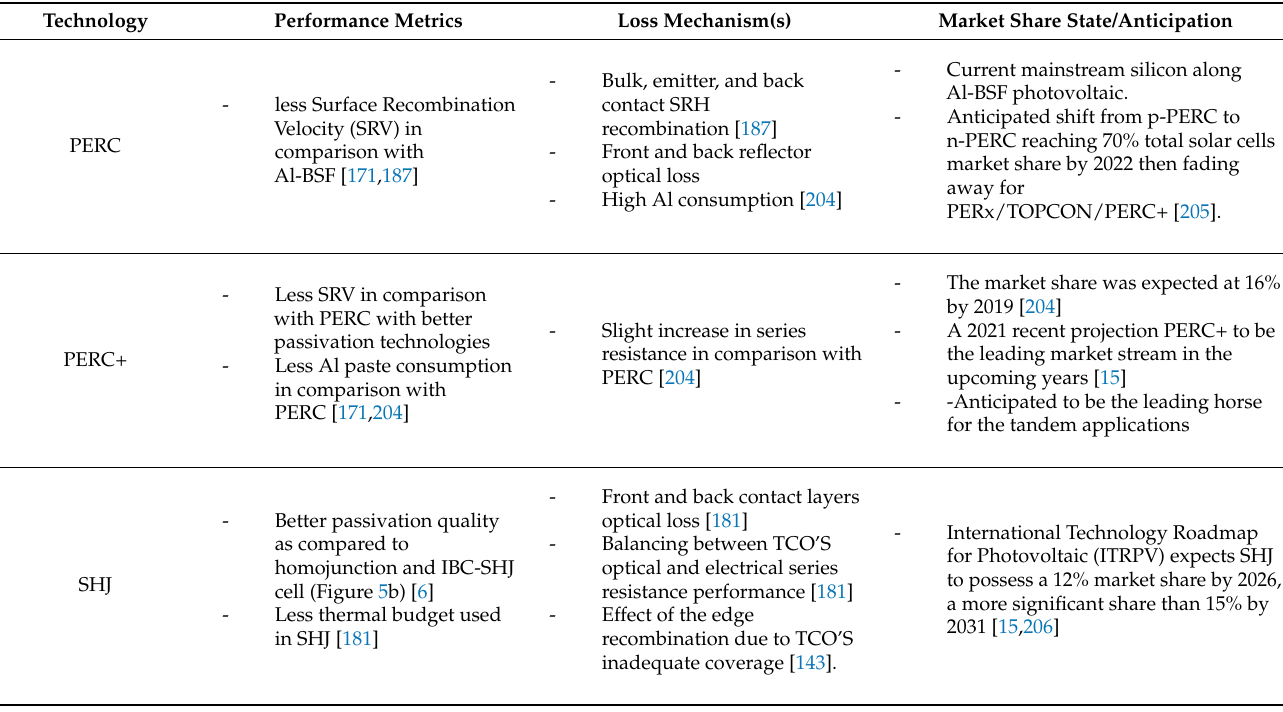
Table 5. The overall performance metrics for a bottom cell selection criteria, loss mechanism (s), and leading silicon technologies market